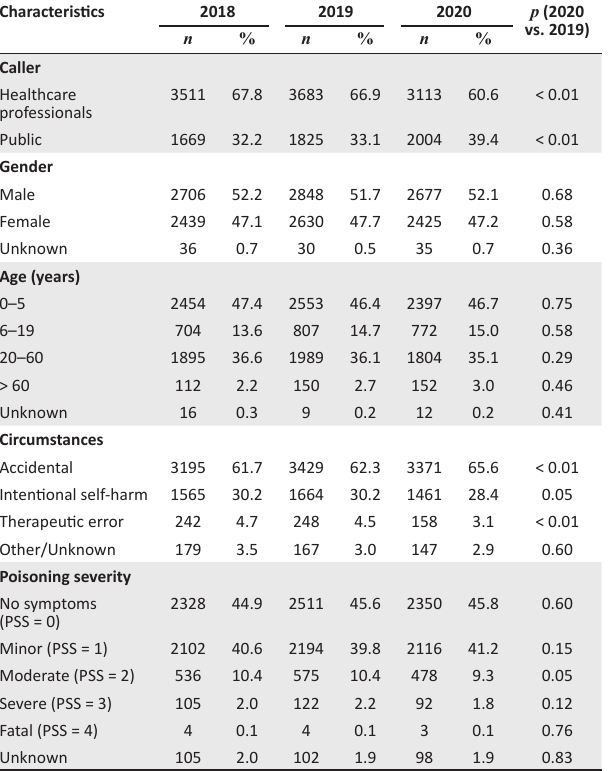
TABLE 1: Characteristics of poisoning exposure calls received by the Poisons Information Helpline of the Western Cape in the first six months of the COVID-19 pandemic and similar periods during 2018 and 2019.